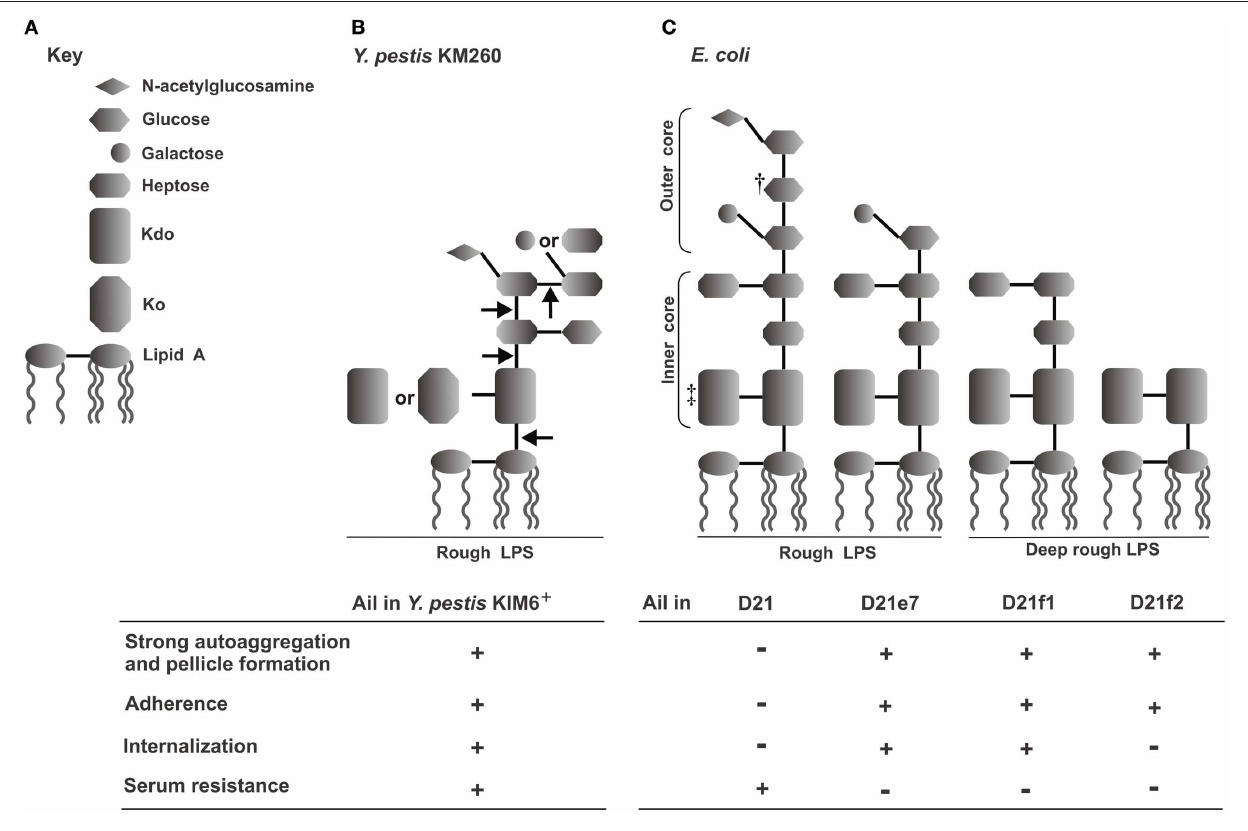
FIGURE 3 | Correlation of E. coli and Y. pestis LPS structures and Ail-mediated phenotypes—schematic representation (Kolodziejek et al., 2010). (A) Key to LPS moieties. (B) LPS core structure of Y. pestis KM260 grown at ambient temperature; arrows indicate truncation of the core residues that resulted in loss of serum resistance (Knirel et al., 2007; Dentovskaya et al., 2011). (C) LPS structures of E. coli K-12 D21 and its isogenic mutants (Yu and Mizushima, 1982; Nikaido and Vaara, 1985; Razatos